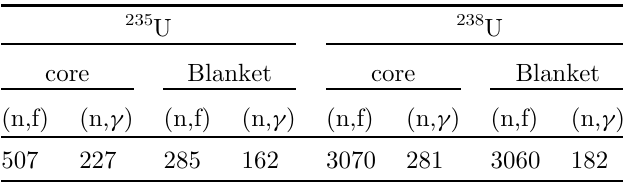
Table 1. Average neutron energy in keV causing fi ssion or capture in the two main zones of the imf7 benchmark.